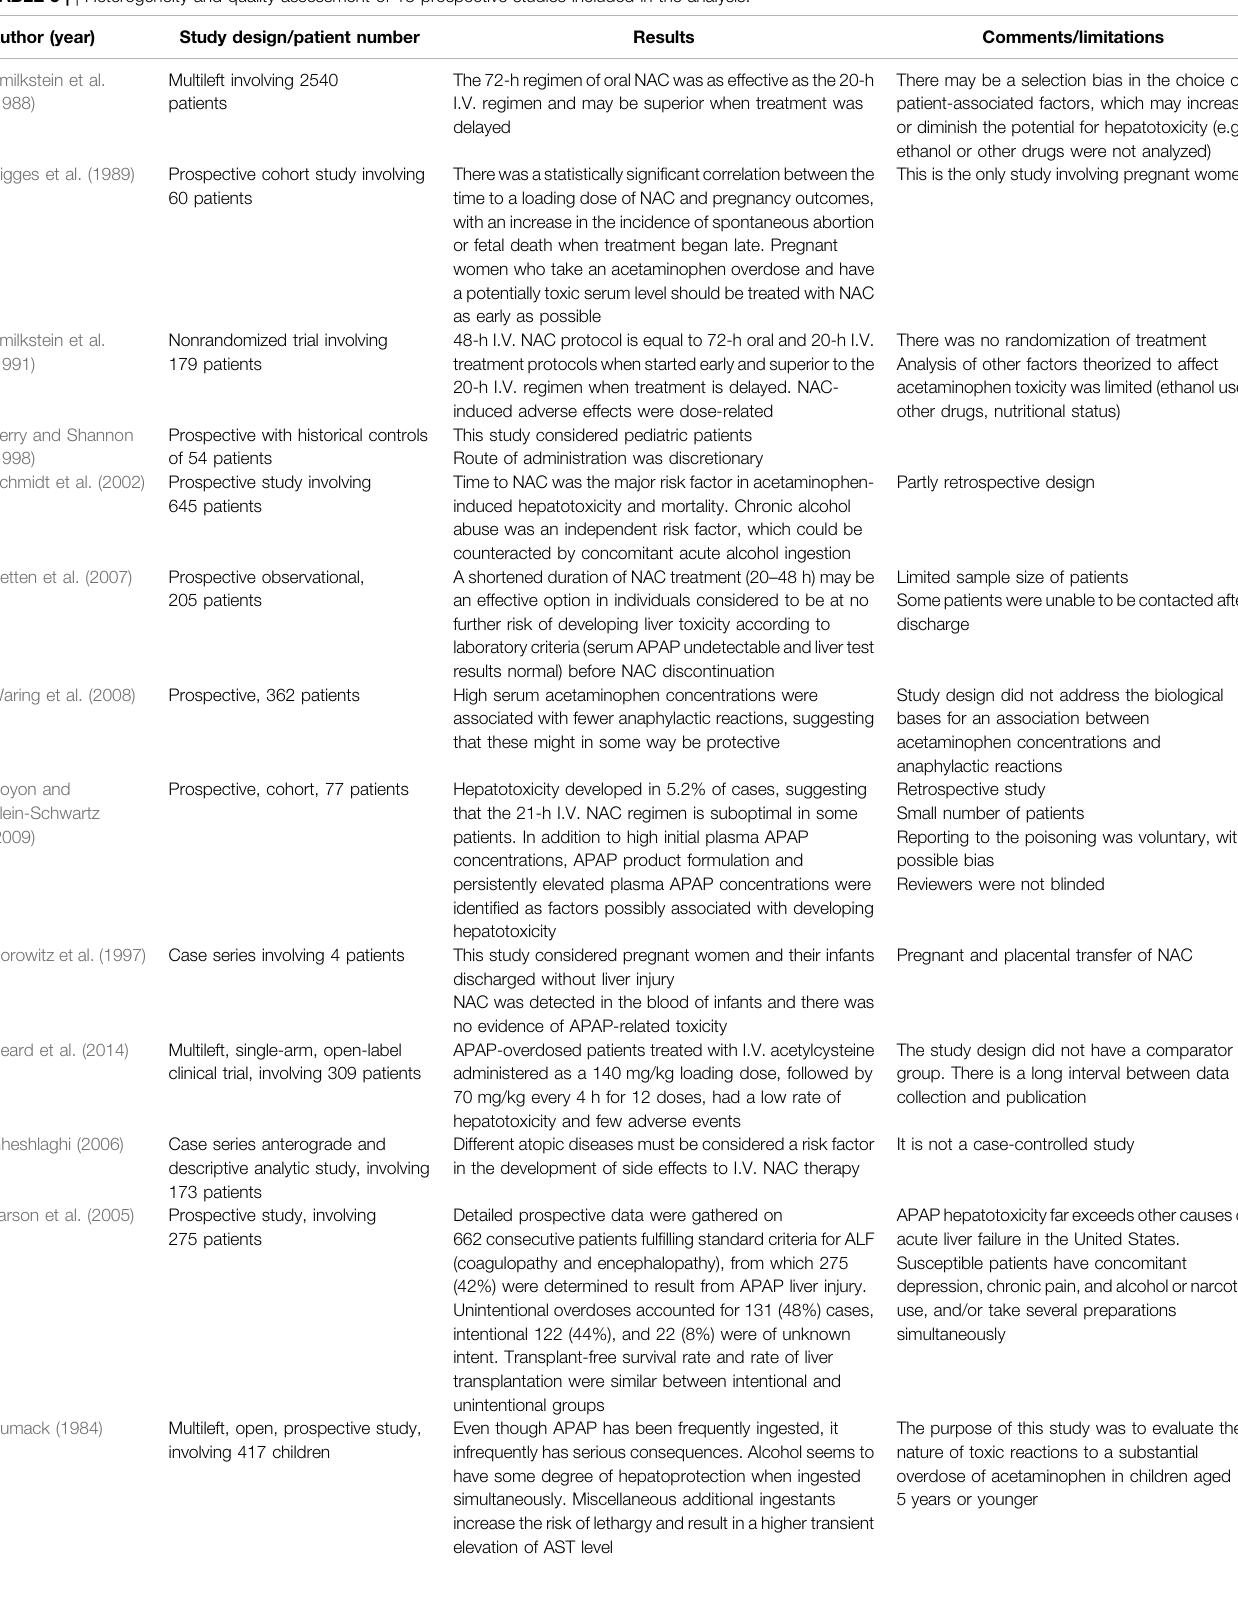
TABLE 5 | | Heterogeneity and quality assessment of 13 prospective studies included in the